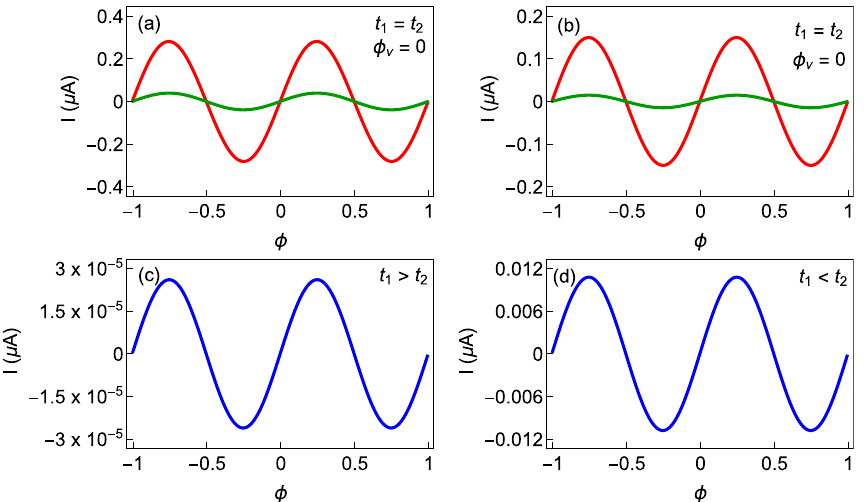
Figure 4. Current-flux characteristics in the half-filled limit where the first row is associated with the AAH ring (without any hopping dimerization, t 1 = t 2 = 1 ), while the second row is for the SSH ring (without AAH modulation, W = 0 ). For the AAH ring, the results for the non-staggered and staggered cases are shown in ( a ) and ( b ), respectively. On the other hand, for the SSH ring, we choose t 1 = 1 and t 2 = 0.5 in ( c ) and in ( d ) we take t 1 = 1 and t 2 = 1.5 . The ring size N = 20 . In the first row, the red and green lines correspond to W = 1 and 1.25,